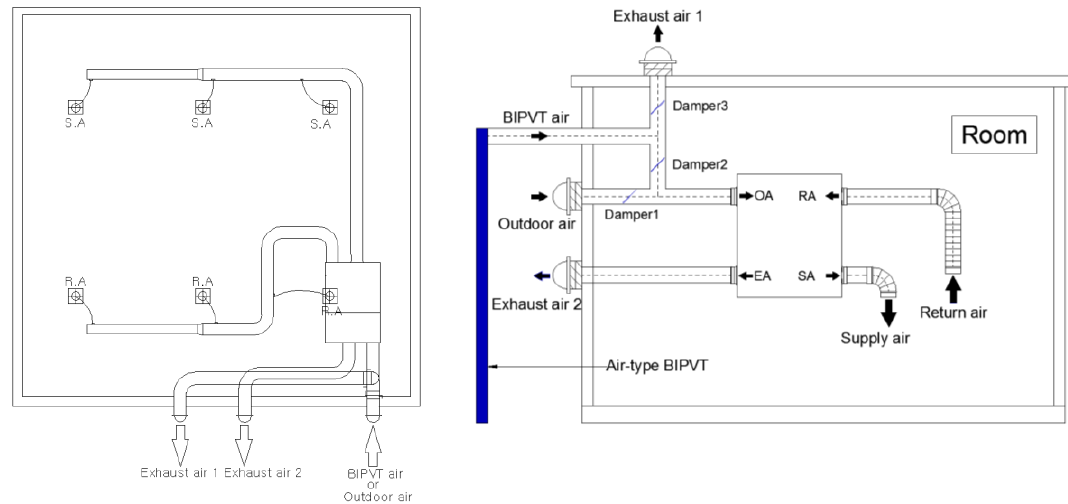
Figure 3. Classrooms installed air handling units with air-type BIPVT collectors.